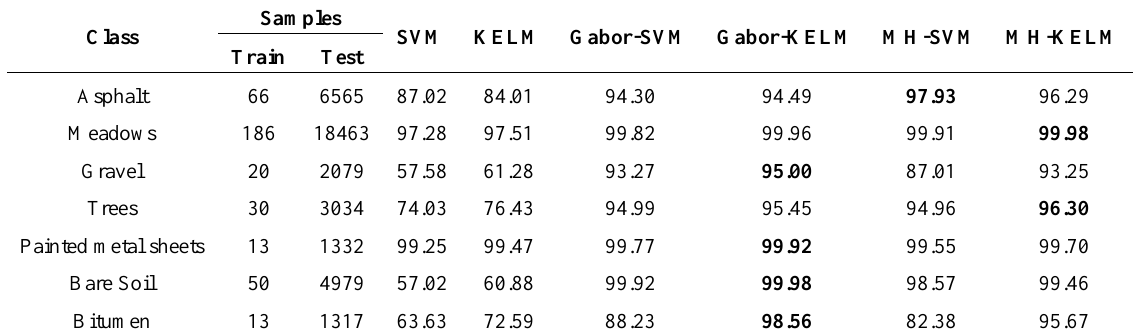
Table 9. Classification accuracy (%) for the University of Pavia dataset (whole